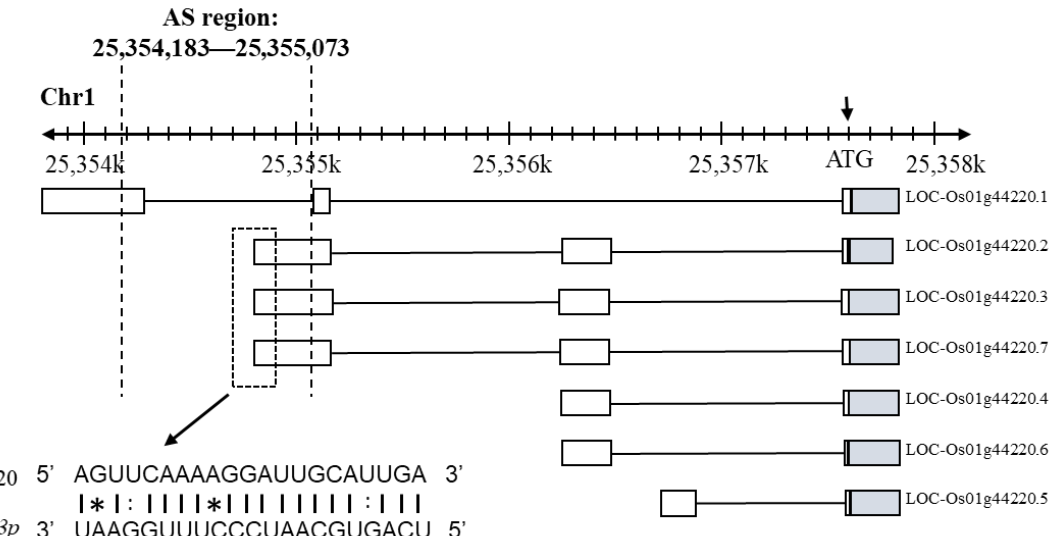
Figure 6. Alternative splicing of the miR393b binding site of OsAGPL2 5′ UTR of rice inferior spikelets under moderate soil drying post-anthesis. White boxes represent noncoding exons and shaded boxes represent coding exons. Dashes indicate Watson – Crick base pairing, colons indicate G-U base pairing, and asterisks indicate other non-canonical pairs.